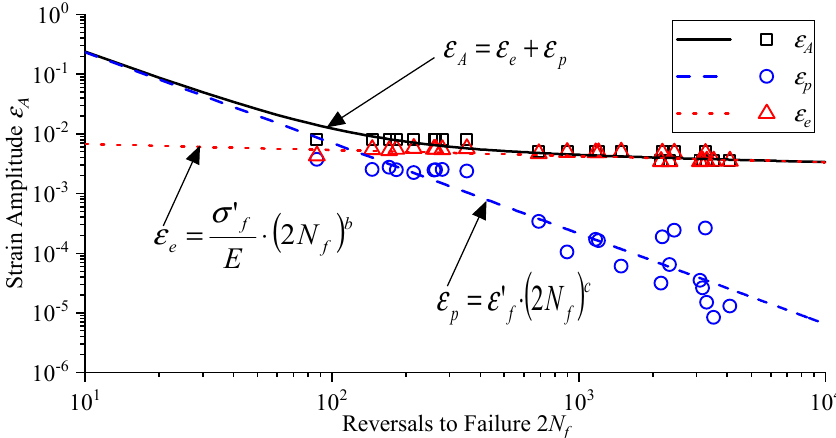
Figure 2. Example of the Coffin–Manson–Basquin curve according to Equation (5) for the as- built